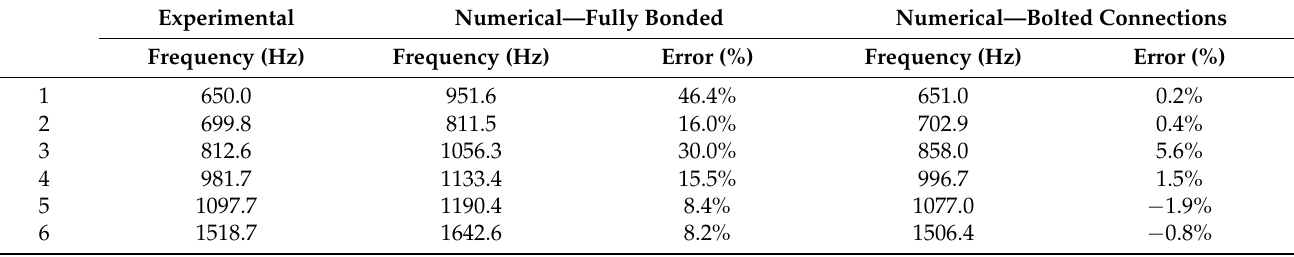
Table 4. Comparison of numerical modal frequencies with the experimental modal frequencies before and after the consideration of the bolted connections. The tested object is the full assembly of the mounting plate and the